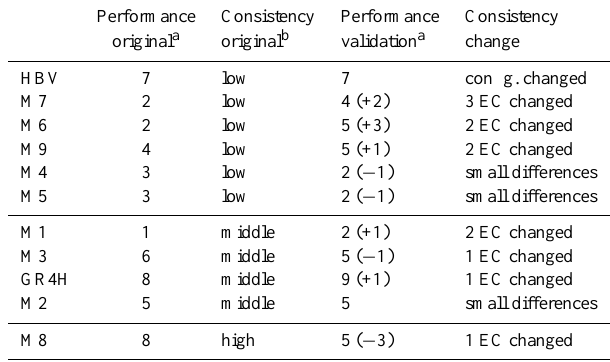
Table 6. Summary of differences between the PCA graphs for the calibration and the independent test period for the Maimai catch- ment (EC=evaluation criterion). The model structures are ordered by consistency in the calibration period. 1, 2 or 3 “EC changed” in the last column means the configuration of the PCA diagram of the calibration and validation are equal, but 1, 2 or 3 vectors have a different direction and/or length. “conf. changed” means that the relative direction of almost all vectors